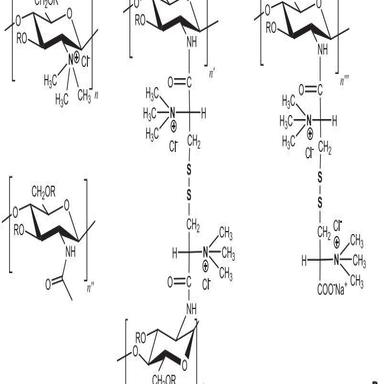
SEM images of chitosan and its derivatives.